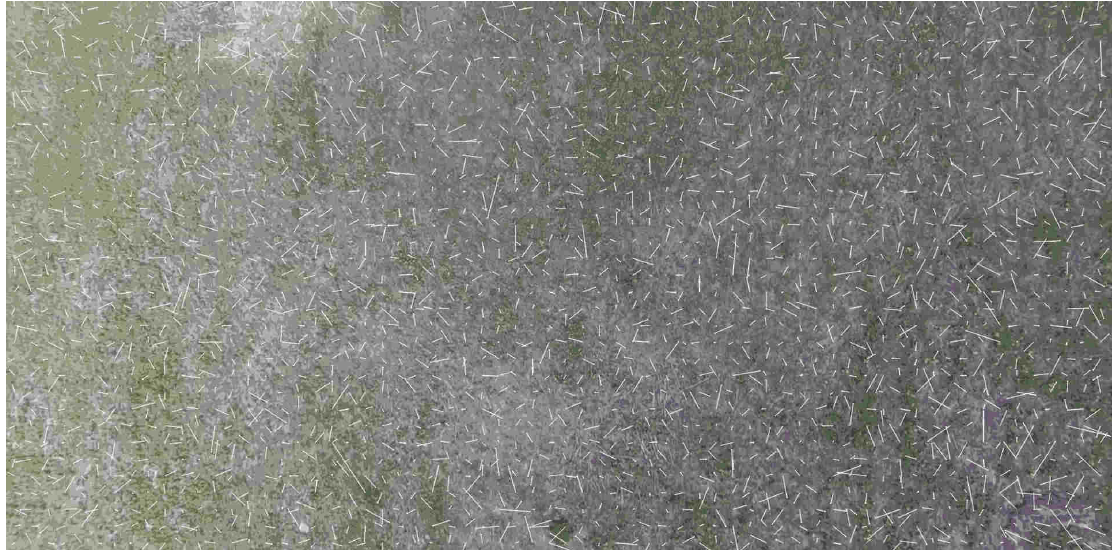
Figure 6. Optical flow estimated by Lucas-Kanade algorithm at the end of glissade, height ≈ 30 m, level of averaging 2 × 2. One can observe the very chaotic nature of the optical flow which prevents the estimation of the flight parameters.